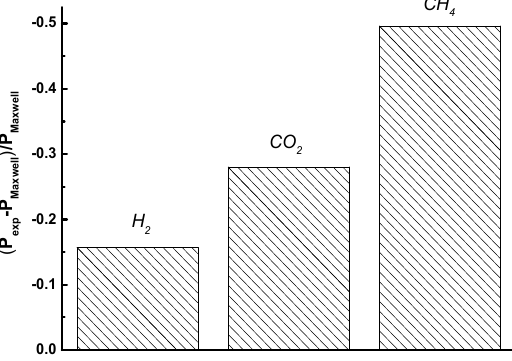
Figure 6. Relative deviation of gas permeability coefficients P exp from P Maxwell for the P84/ND membrane .